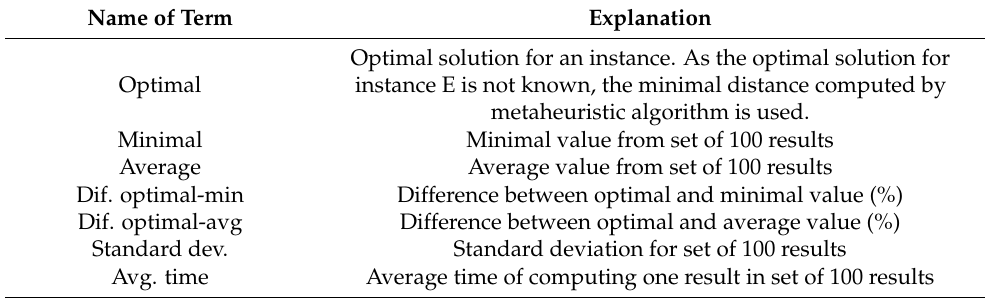
Table 4. Definitions of terms used.